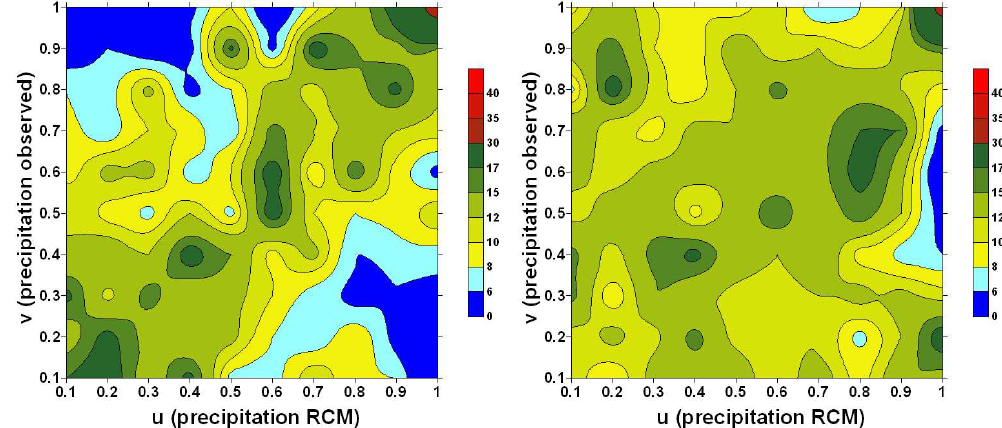
Fig. 8. Empirical Copula density for modelled ( u ) and observed precipitation ( v ) for station Garmisch-Partenkirchen, using the positive pairs of original data (left), and the positive pairs of the ARMA-GARCH transformed iid residuals (right).